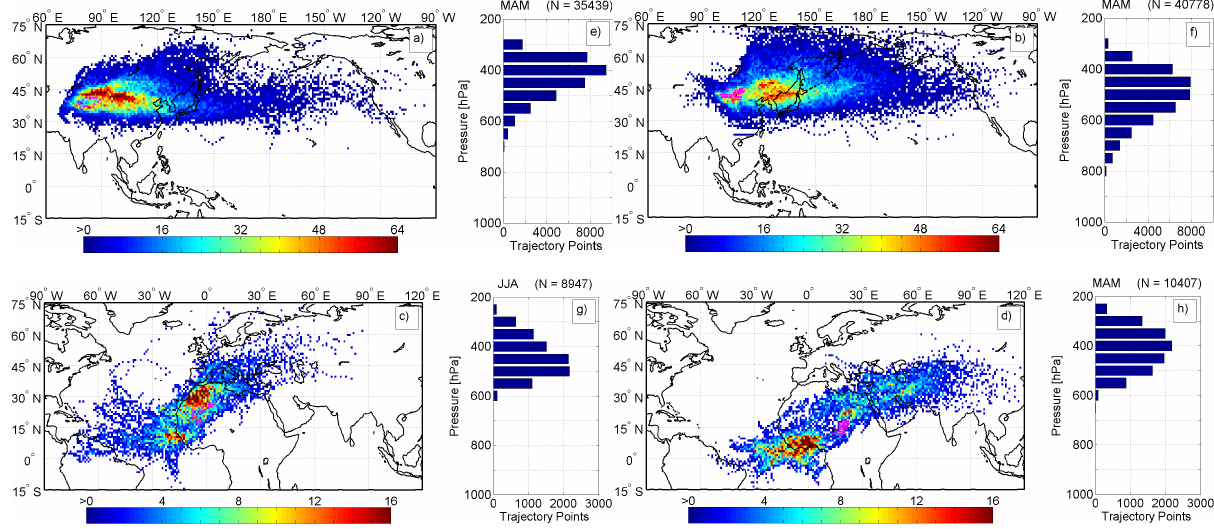
Fig. 9. Absolute number of trajectory points (in 1 ◦ × 1 ◦ bins) classified as MPC clouds in trajectories originating from (a) Taklimakan, (b) Gobi, (c) West Africa and (d) Bod´el´e. Respective pressure [hPa] distributions are shown in panels (a–h) . All panels show spring (MAM), except for (c) and (g), which show summer (JJA). Trajectory starting points are shown in magenta, with only perimeter points shown in the Taklimakan, for clarity.